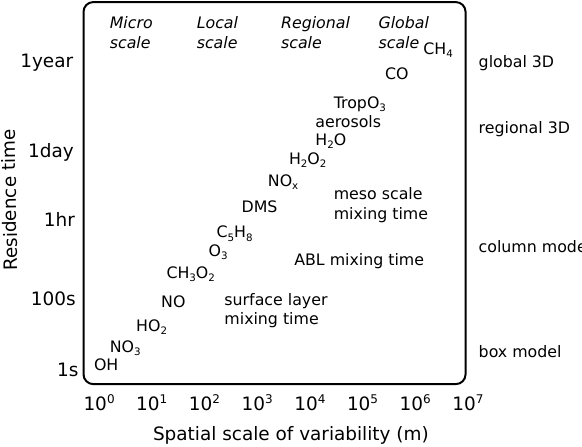
Figure 1. Spatio-temporal scales in atmospheric chemistry, typi- cal species associated with these scales and the type of model that should be used to study their behaviour in the